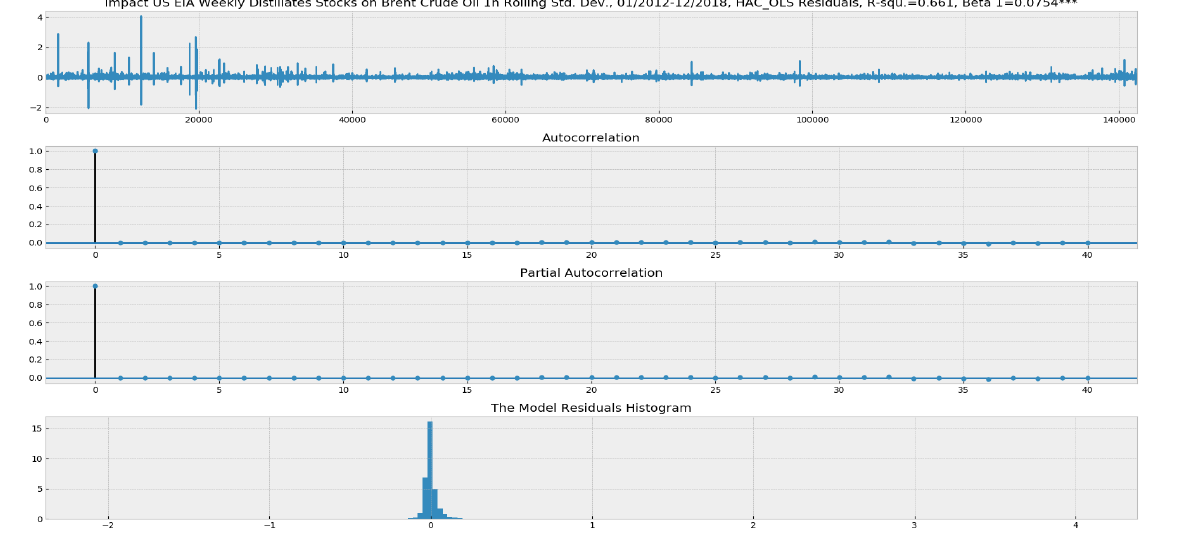
Figure 3: Model Residuals. ACF/PACF-plot and Histogram-plot of EIA Weekly Distillates Stocks on Brent Crude Oil 1hour window rolling standard deviation from (Jan. 2012 - Dec. 2018); Source: Faseli,